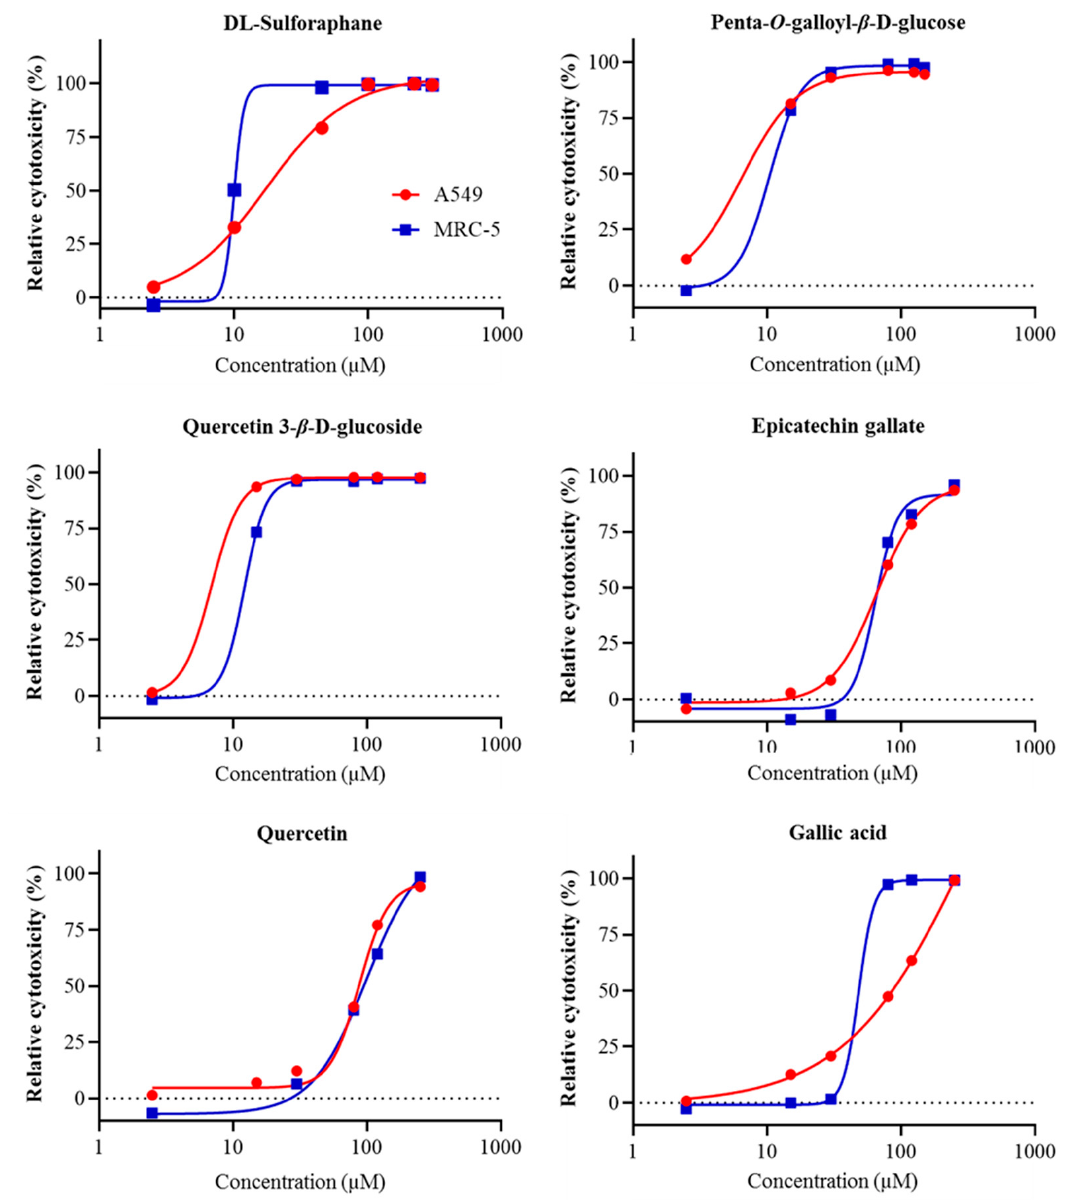
Figure 3. Cytotoxicity (%) of phenolic compounds (penta- O -galloyl- β - d -glucose, quercetin 3- β - d -glucoside, gallic acid, epicatechin gallate, ellagic acid) and the control ( dl -sulforaphane) in A549 and MRC-5 cell lines. Data are expressed as percentages of cytotoxicity in A549 and MRC-5 cells treated with DMSO and the compounds compared with the corresponding vehicle controls that were A549 and MRC-5 cells treated with 0.35% DMSO